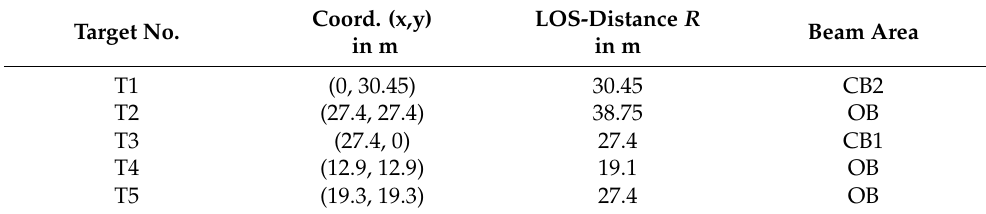
Table 1. Target plan and properties.